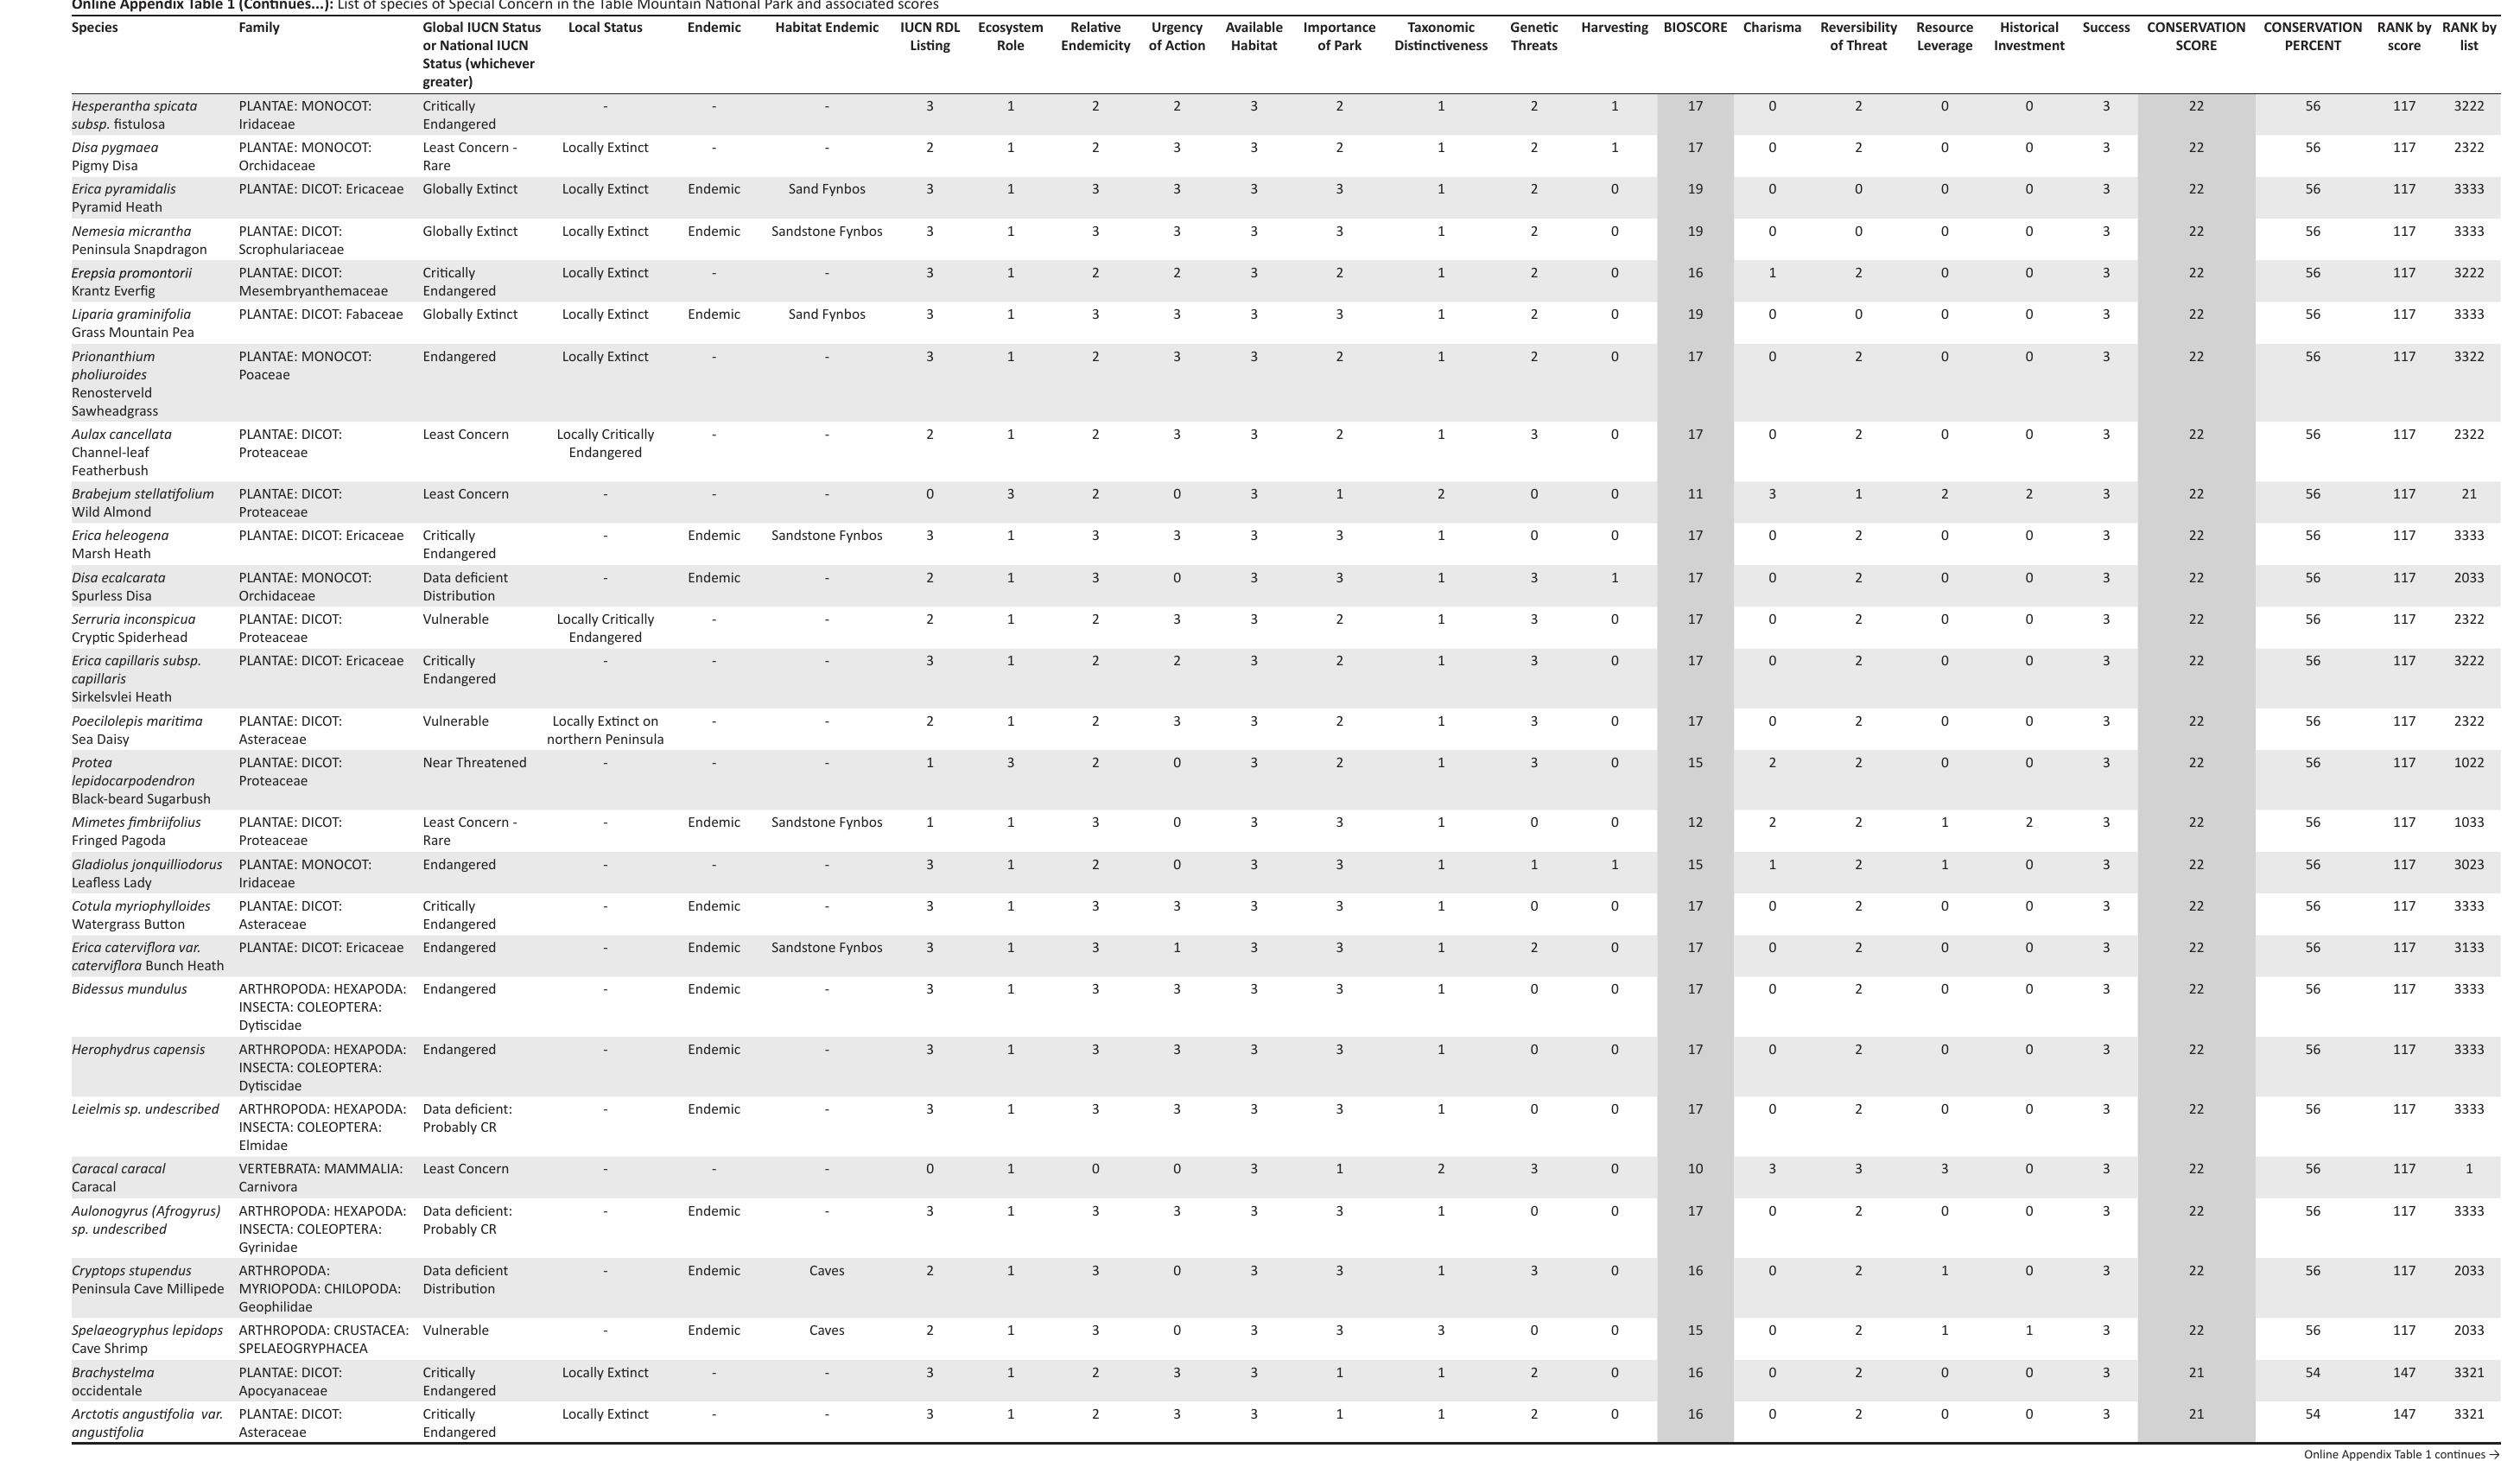
Online Appendix Table 1 (Continues...): List of species of Special Concern in the Table Mountain National Park and associated